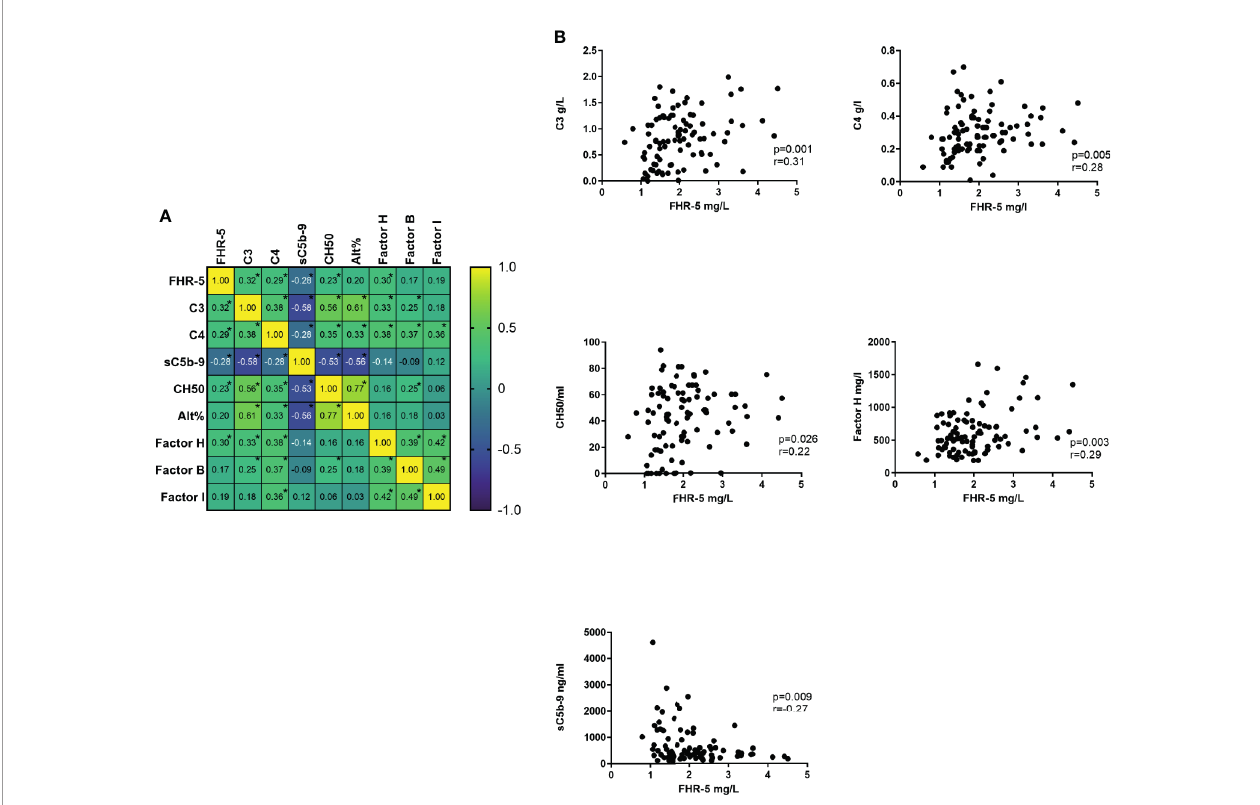
FIGURE 5 | (A) Correlation heat map of different complement parameters. Number in boxes indicates Spearman correlation r. *p < 0.05. (B) Signi fi cant correlation of Factor H-related protein 5 (FHR-5) and other complement